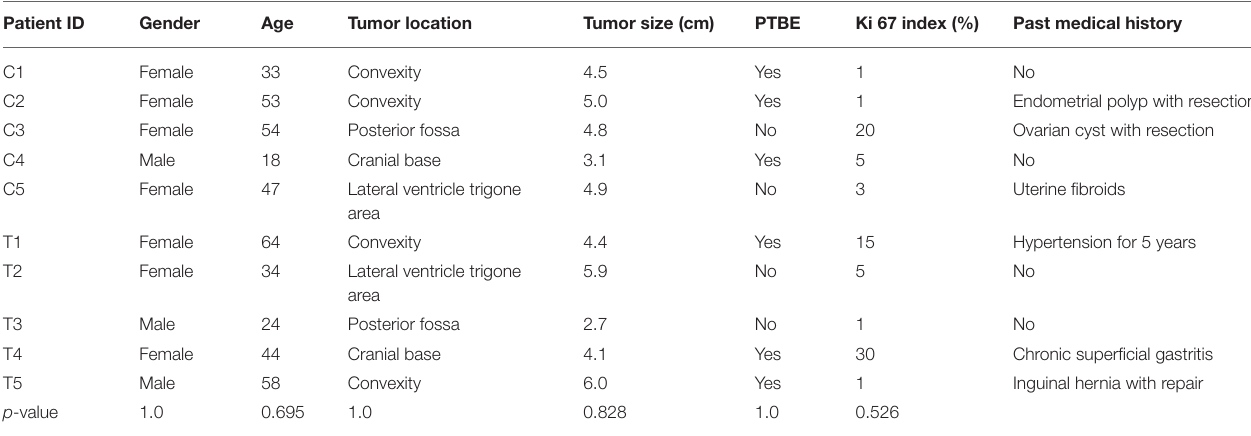
TABLE 2 | Clinical characteristics of patients whose tumor was detected by microRNA (miRNA) microarray. Patient